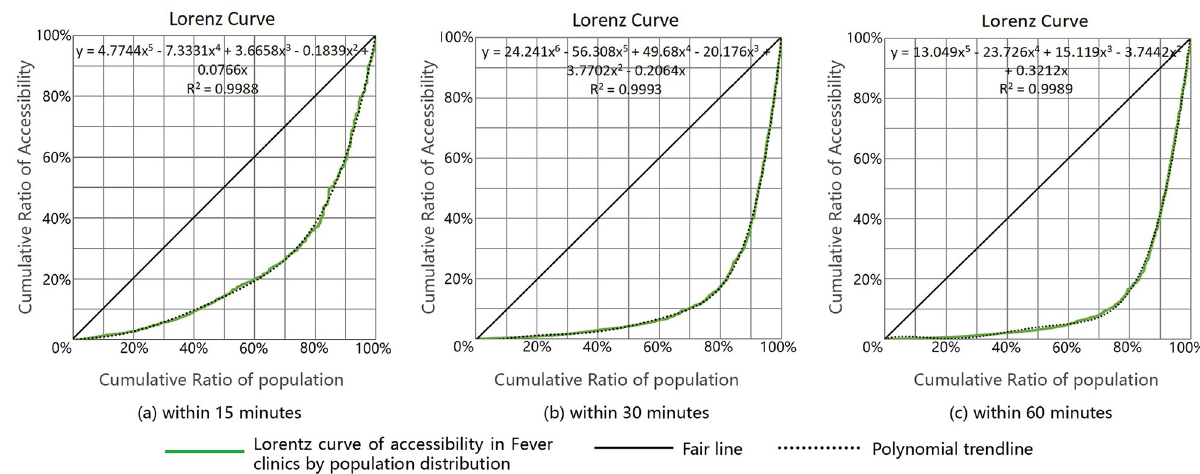
Fig 11. Lorentz curves of accessibility to fever clinics by population distribution. (a)Within 15 minutes, (b) Within 30 minutes, (c) Within 60 minutes.